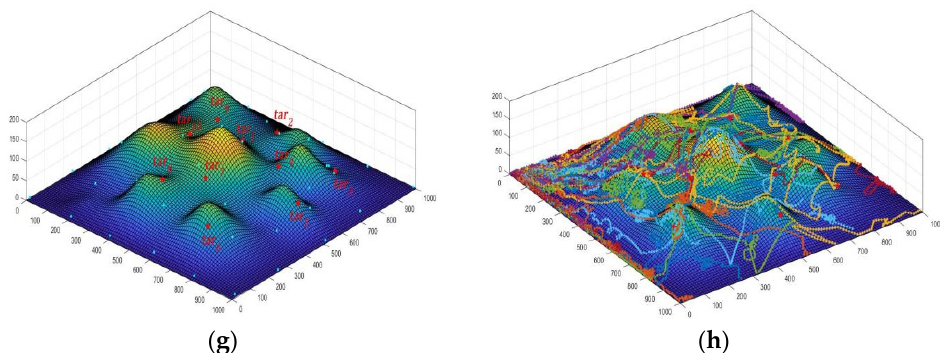
Figure 5. 3D search simulation diagram. ( a ) Target search terrain, ( b ) When t = 1, the robot and the target are located, ( c ) When t = 37, a robot detects a target signal and forms a suballiance. ( d ) When t = 1~58, a robot searches the trajectory of target tar 8 . ( e ) When t = 127, the target is found. ( f ) When t = 1~185, the trajectory of the robot. ( g ) When t = 255, all targets have been found. ( h ) When t = 1–255, the trajectories of all the robots.